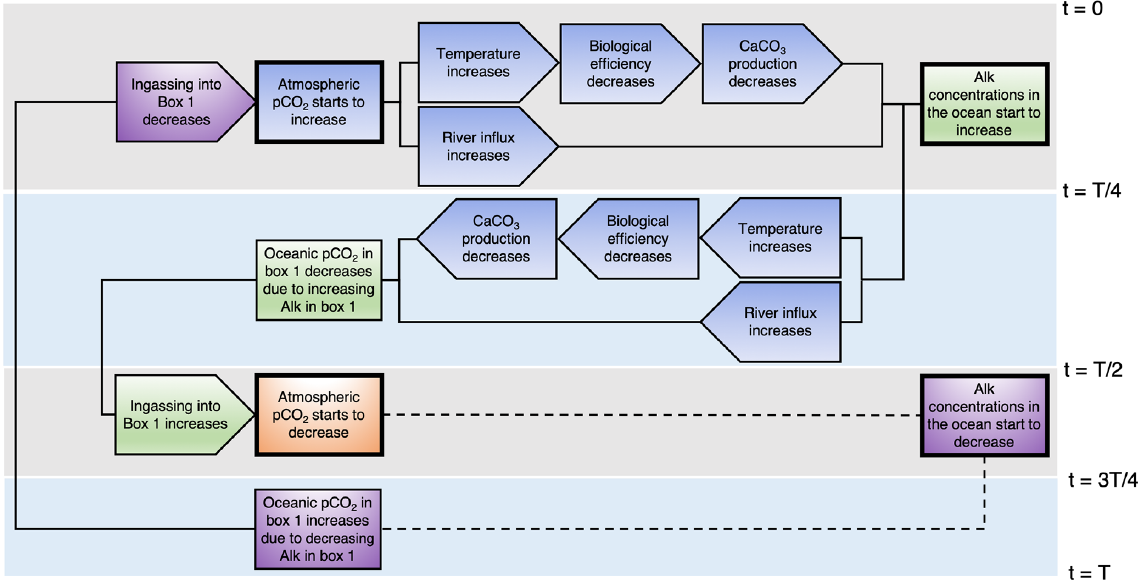
Figure 6. Schematic representation of the mechanism of the internal oscillation. The rectangles represent state variables, while the pointed blocks represent fluxes or model parameters. Some boxes have thicker outlining. These boxes cause a chain of events. The chains corre- sponding to the box are the boxes with the same color shading. The gray and blue rectangles in the background represent a quarter period. In the second half of the period, processes are replaced with a dashed line. These processes are the opposite of what happens in the first half of the